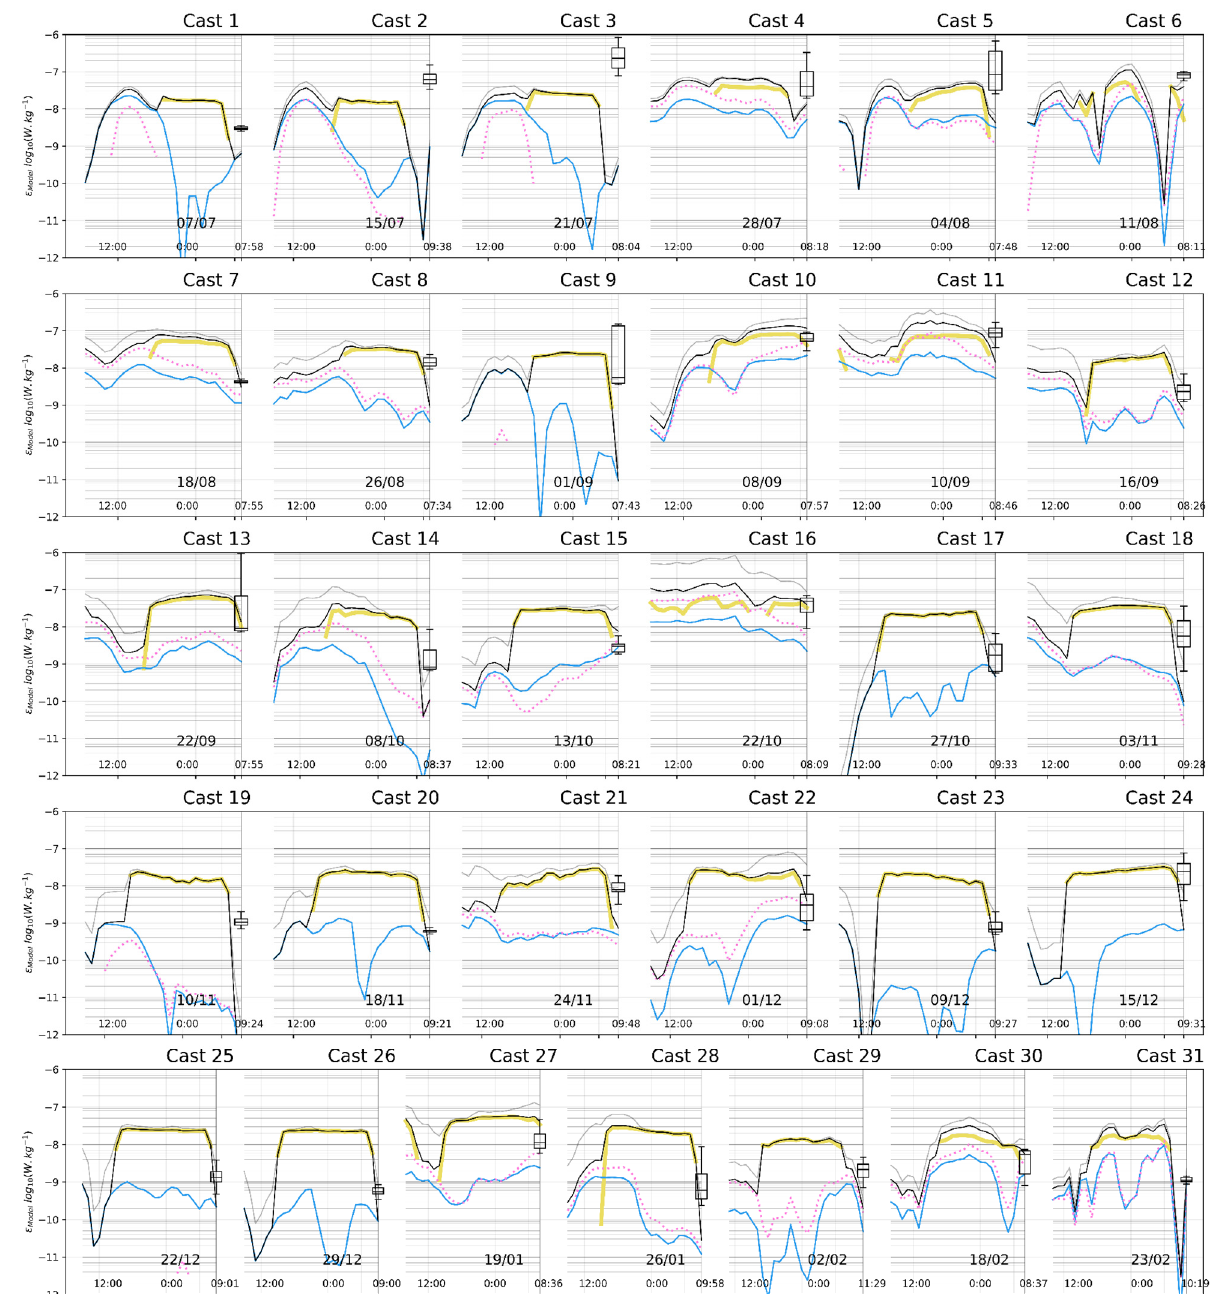
Figure 6. Time series of ε B 12 . Total of the dissipation rates (black) and its decomposition through the contributions of the wind stress (blue), the buoyancy fluxes (yellow), the wind–wave Langmuir regime (pink). Here, we show 24 h before each cast. Model is evaluated at h = MLD (and at h = z surface to provide an upper limit, shown in gray). Boxplots of ε in situ (bin: surf ace − MLD , excluding the first meters) are shown on the vertical line indicating the moment of the